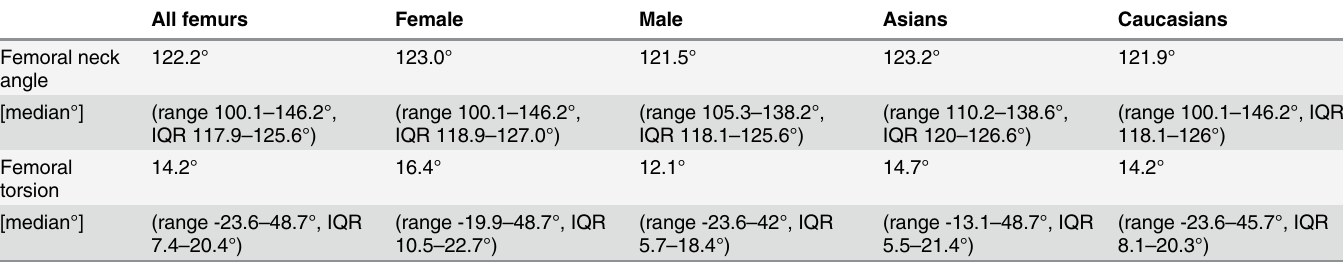
Table 1. Provides a summary of femoral neck and torsion angles found the cohort. All